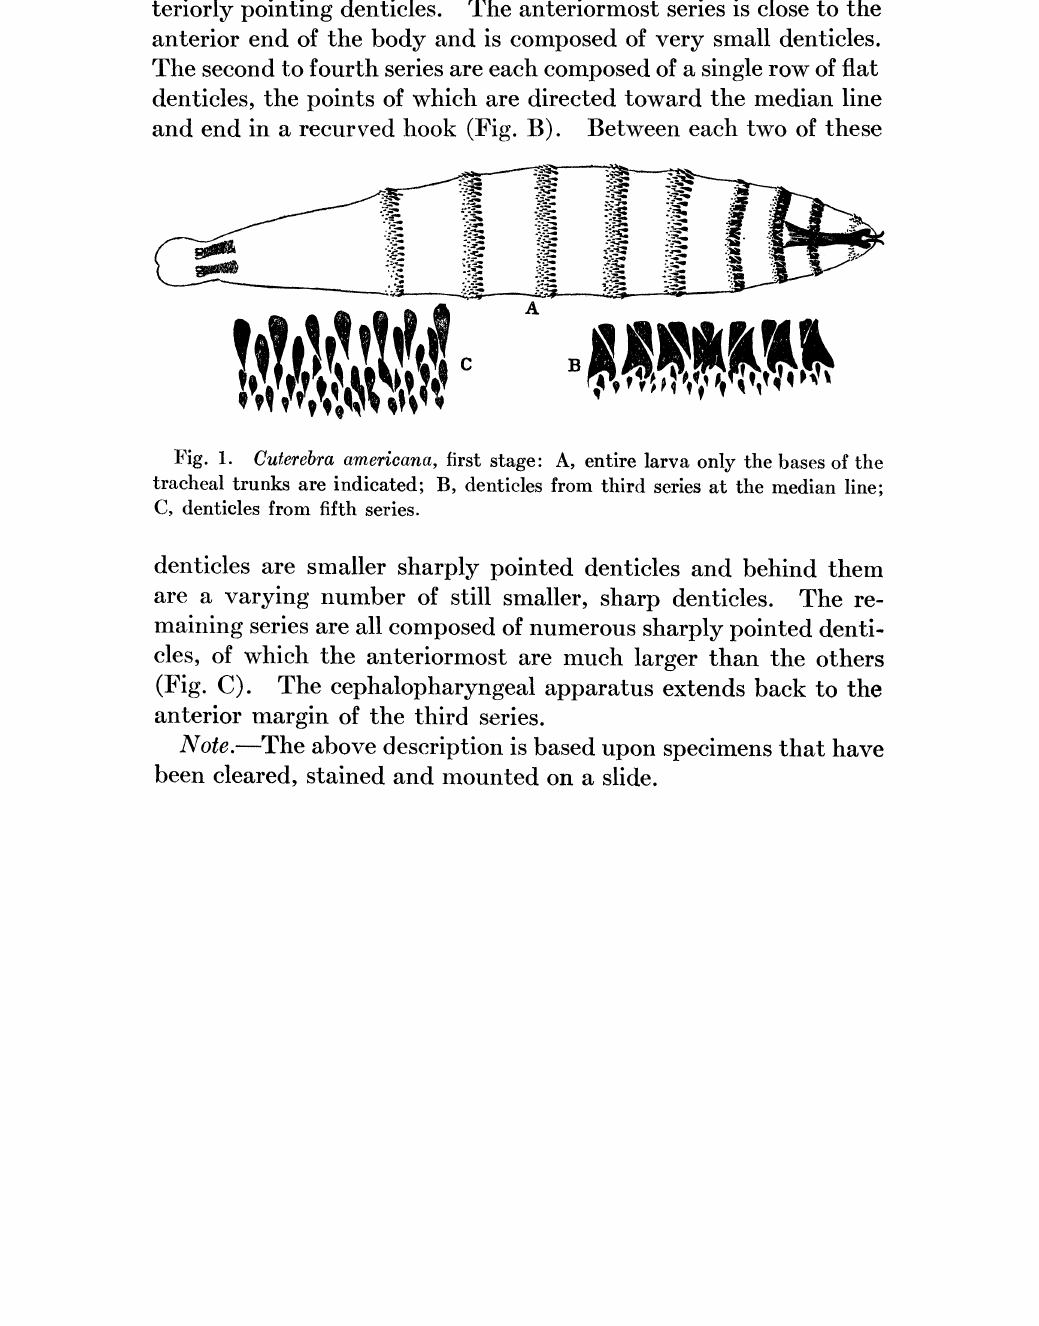
Fig. 1. Cuterebra americana, first stage: A, entire larva only the bases of the tracheal trunks are indicated; B, denticles from third series at the median line; C, denticles from fifth